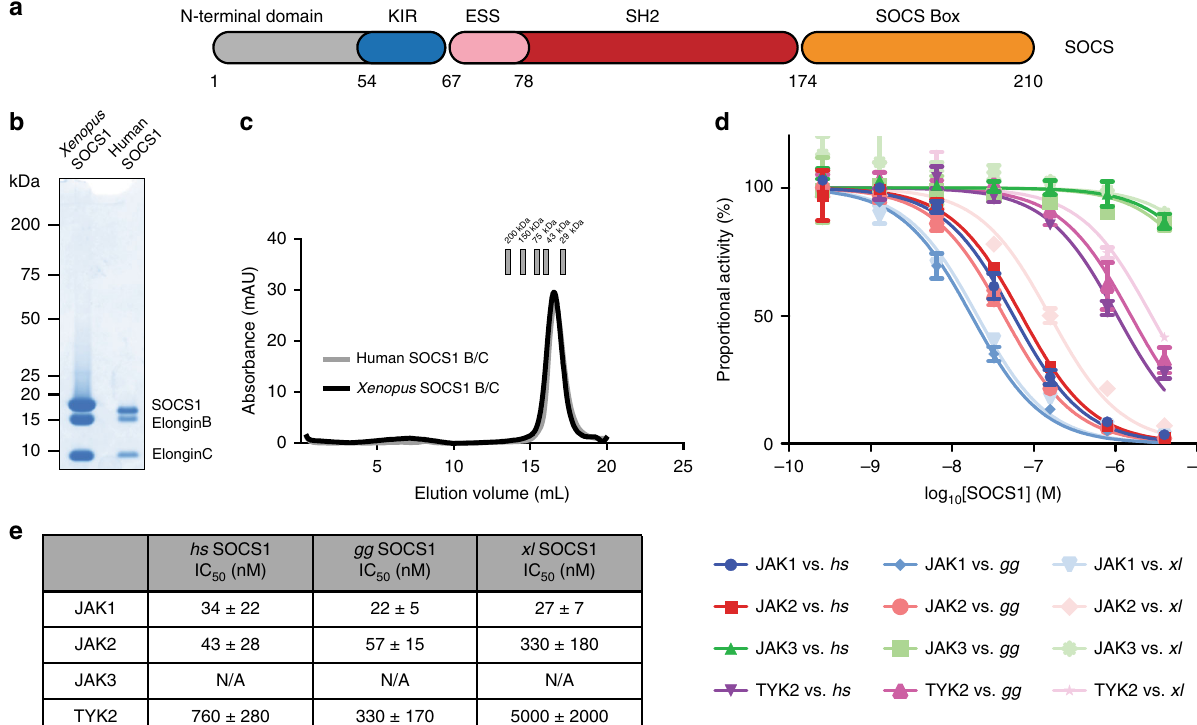
domains 3 . In addition to their ubiquitin ligase activity, SOCS1 and SOCS3 are unique in also having the ability to directly inhibit the kinase activity of JAK 4 . This activity relies upon a short motif, which is immediately upstream of the SH2 domain, known as the KIR (kinase inhibitory region).